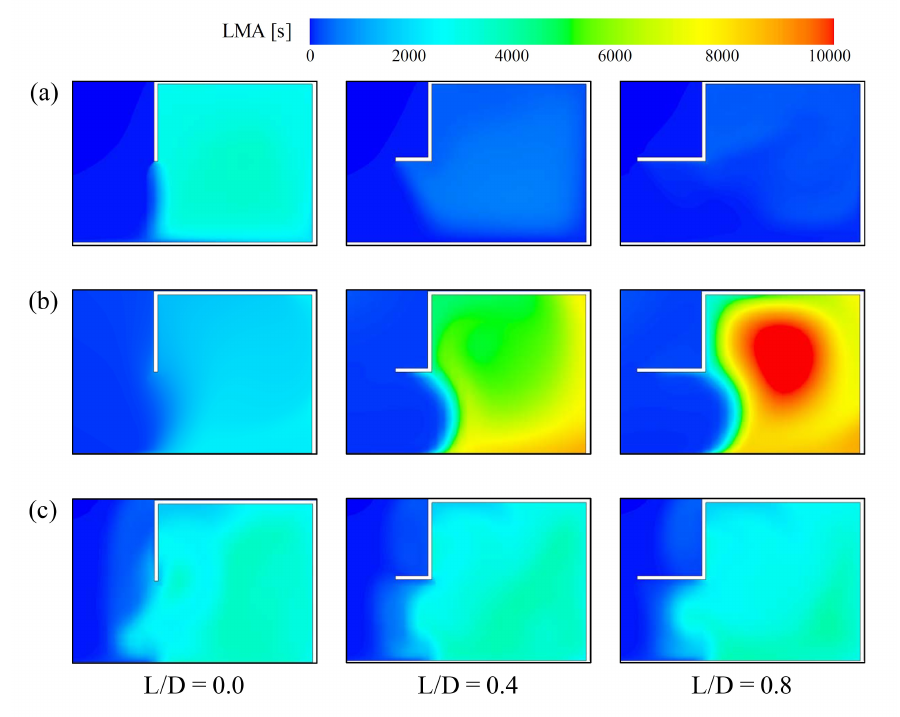
Figure 10. Contour plots of local mean age of air (LMA) for a single-sided building with different overhang lengths ( L / D ) at U R = 1 m/s in the ( a ) windward; ( b ) leeward; and ( c ) side